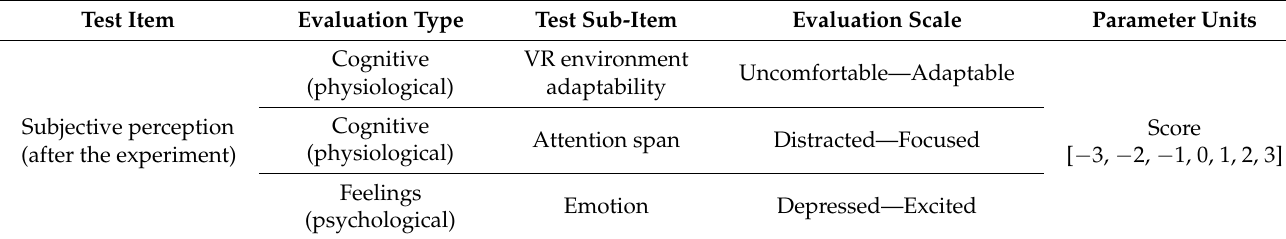
Table 4. Subjective Feelings